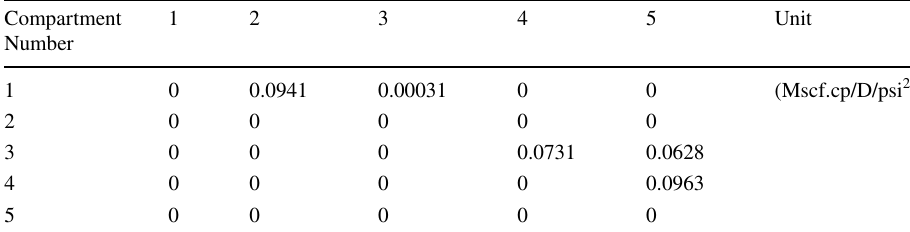
parameters for layer 1 in field case 1